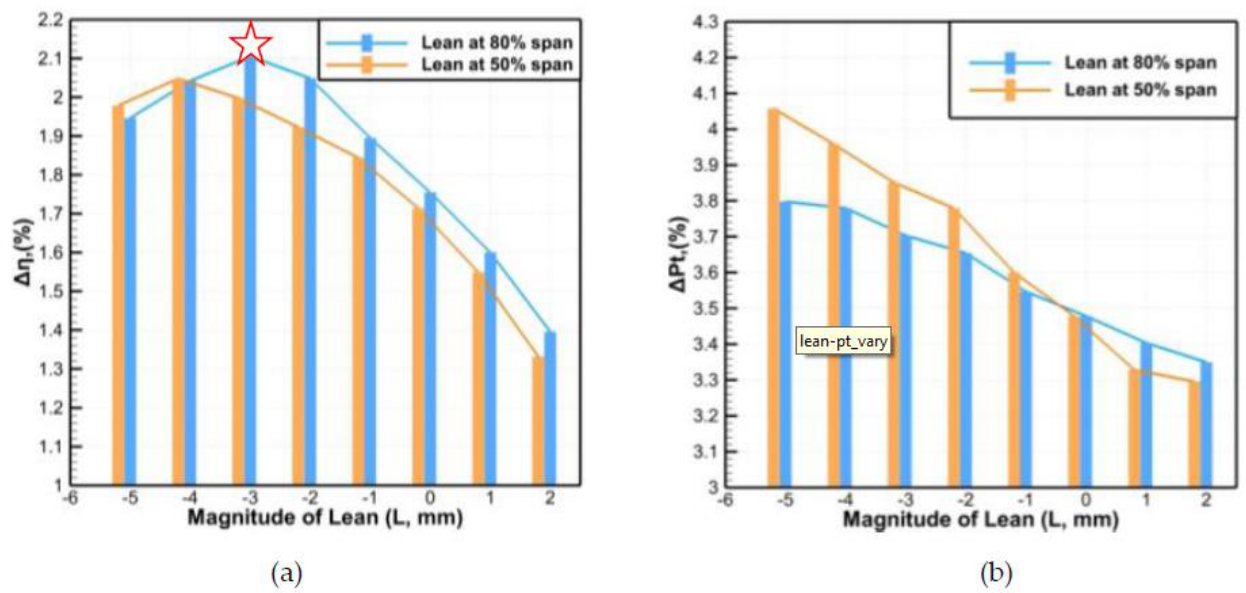
Figure 19. The effect of inducer lean on the compressor performance at the P.E. points. ( a ) Isentropic efficiency, and ( b ) total pressure ratio.